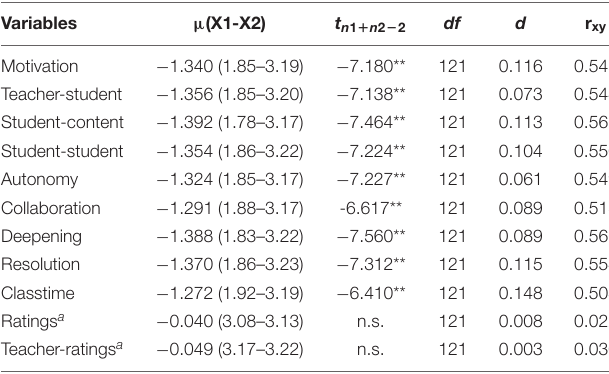
TABLE 3 | Study of the value of independence between control group and experimental